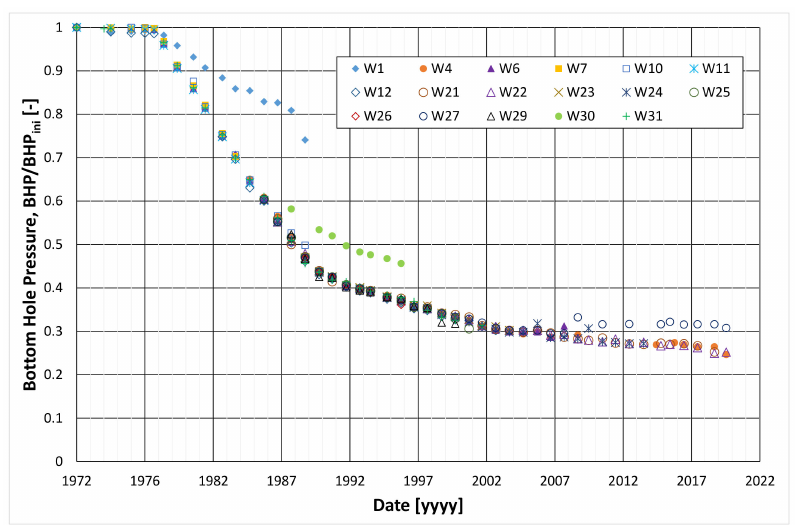
Figure 16. Bottom-hole pressure of producing wells. Three trends identified as indicated by: (1). W1, (2). W30, (3). The other wells: W4, W6, W7, W10–W12, W21–W27, W29, W31.